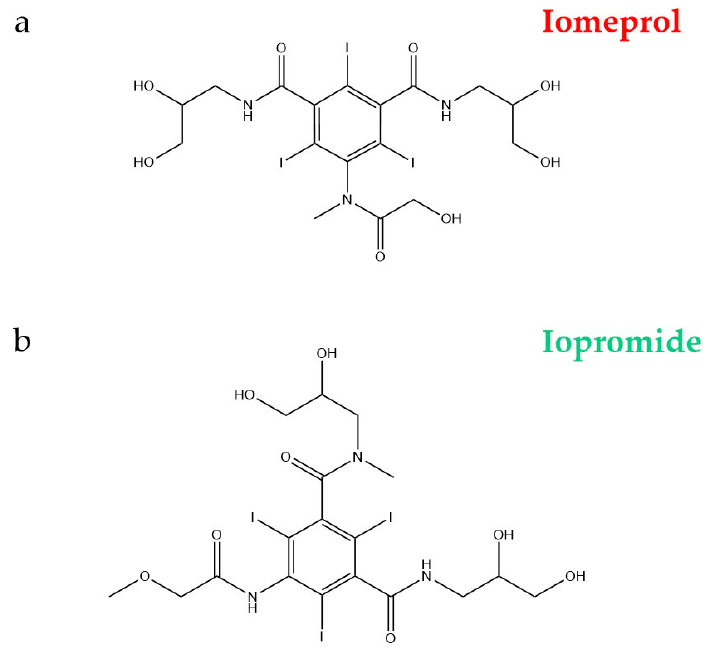
Figure 5. Molecular structure of two contrast agents: ( a ) Iomeprol; ( b ) Iopromide. Table 2. General textural properties of TiO 2 -based photocatalysts. * particles size based on TEM images and/or Scherrer calculation. Adapted from [44].